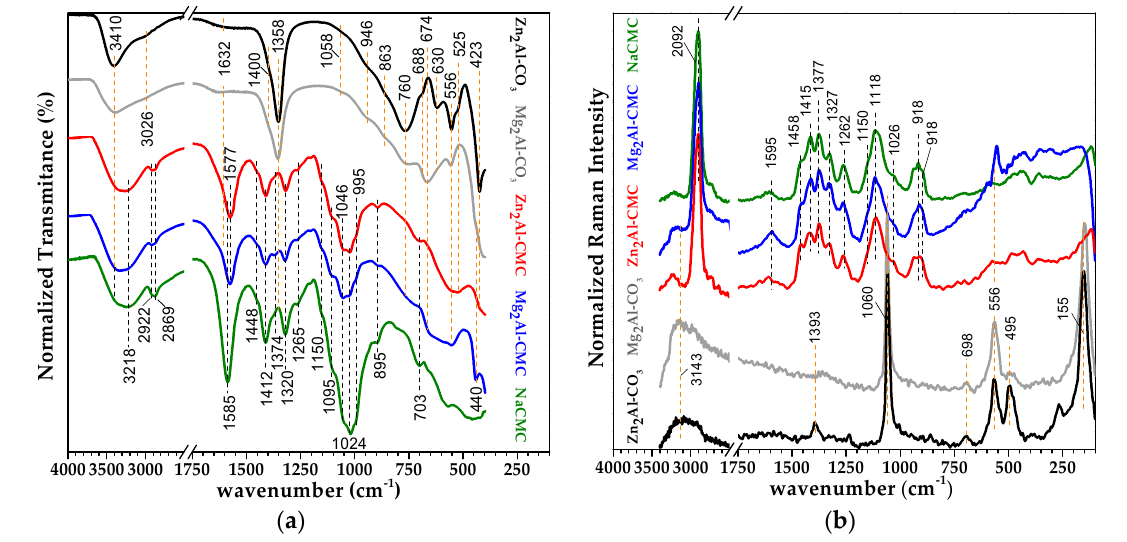
Figure 4. FTIR-ATR ( a ) and FT-Raman ( b ; λ exc = 1064 nm) spectra of Zn 2 Al-CO 3 (black), Mg 2 Al-CO 3 (grey), Zn 2 Al-CMC (red), Mg 2 Al-CMC (blue) and sodium carboxymethylcellulose (NaCMC, green). Table 1. Vibrational spectroscopic data of sodium carboxymethylcellulose.